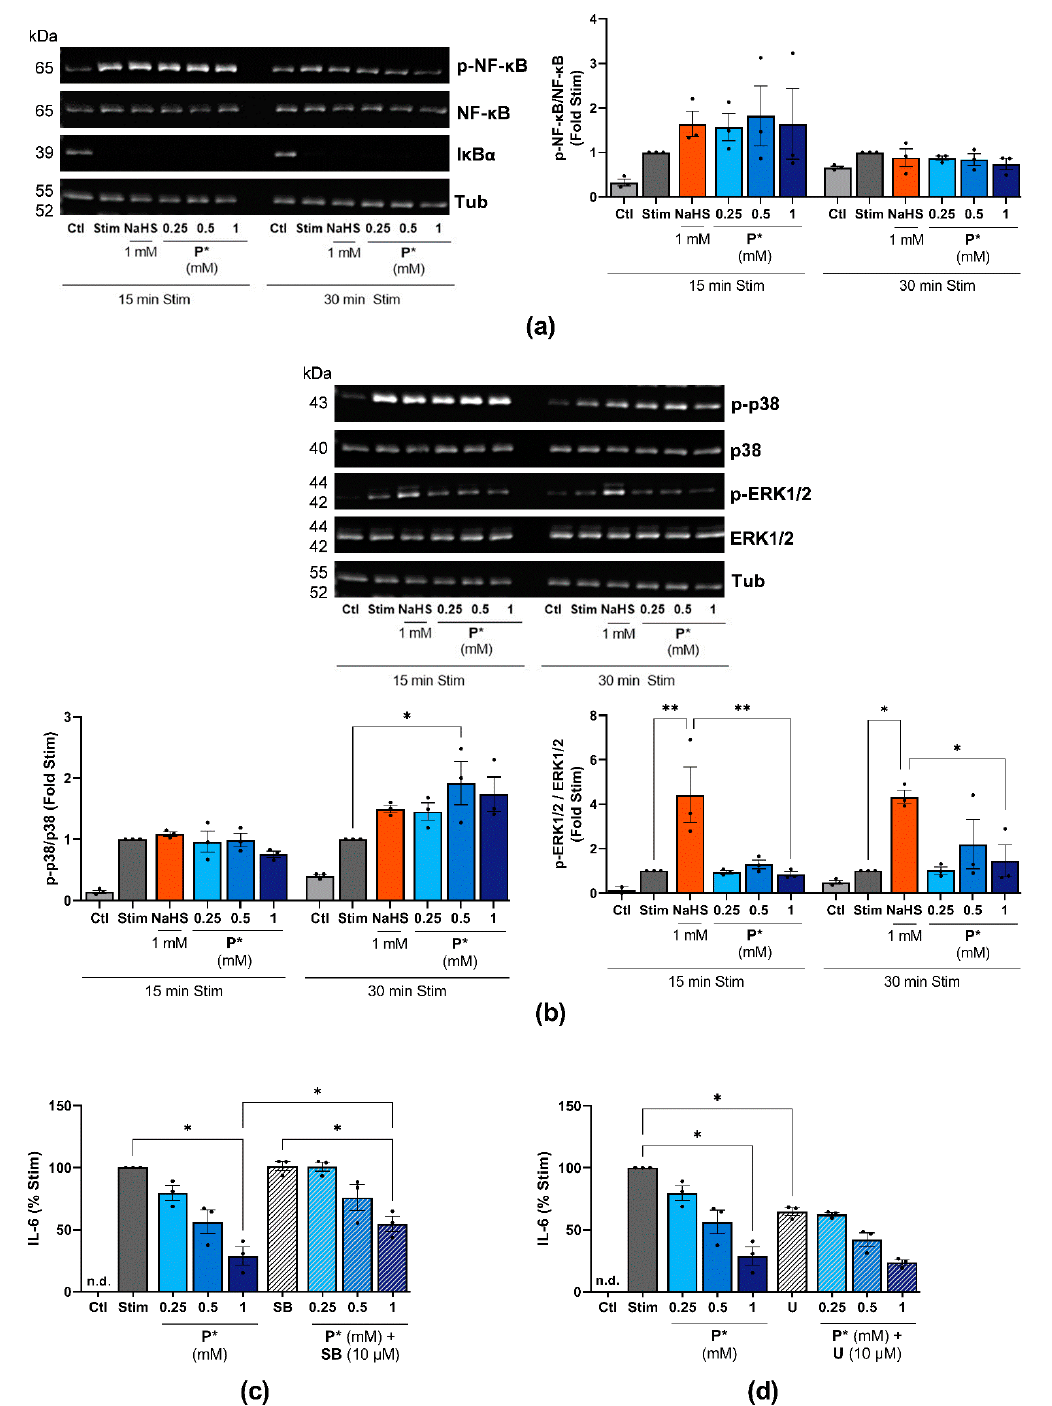
Figure 9. Influence of P* on NF- κ B and MAPK signaling pathways. Ctl = untreated cells, n.d. = non-detected. ( a , b ) ATDC5 cells were incubated with NaHS or P* for 1 h and stimulated with IL-1 β /IFN- γ for 15 or 30 min. Representative Western blots of ( a ) p-NF- κ B, NF- κ B, I κ B α , and α , β -tubulin (Tub), or ( b ) p-p38, p38 MAPK, p-ERK1/2, ERK1/2, and Tub expression. Densitometry analysis values were normalized against ( a ) Tub or ( b ) the equivalent unphosphorylated protein, respectively, and then compared with stimulated cells (Stim) set to 1, n = 3. p -values for all concentrations are shown, * p < 0.05, ** p < 0.01. ( c , d ) ATDC5 cells were treated with ( c )10 µM SB203580 (SB) or ( d ) 10 µM U0126 (U) for 1 h and subsequently with the indicated concentrations of P* for 6 h. The medium was exchanged, and the cells were stimulated for 24 h with IL-1 β /IFN- γ . IL-6 levels were assessed by ELISA and normalized to Stim (100%), n = 3, * p <